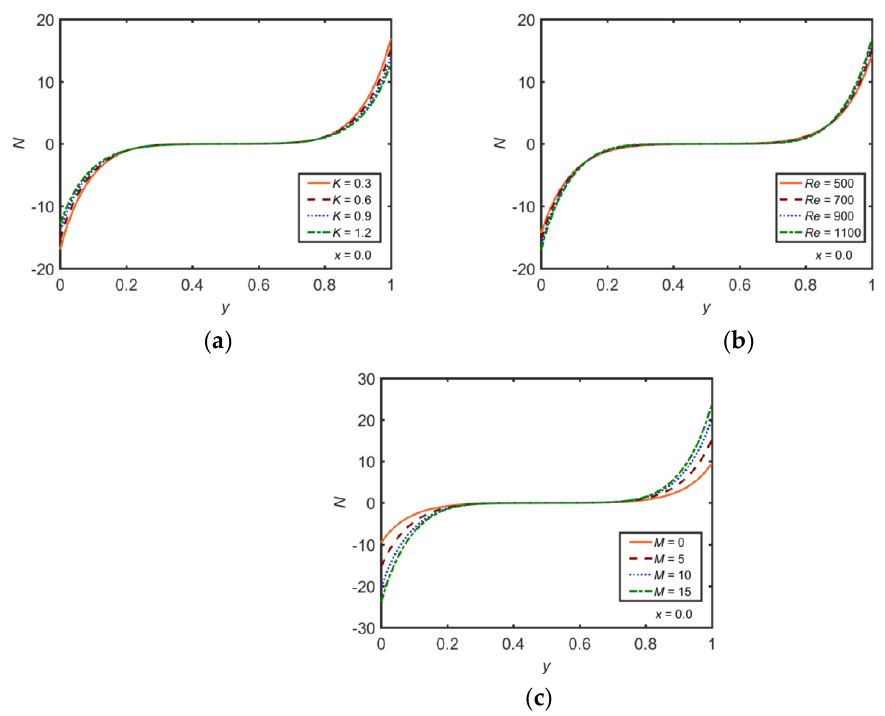
Figure 9. Effects of ( a ) micropolar parameter ( b ) Reynolds number, and ( c ) Hartmann number on micro-rotation velocity profile at t = 0.25 .